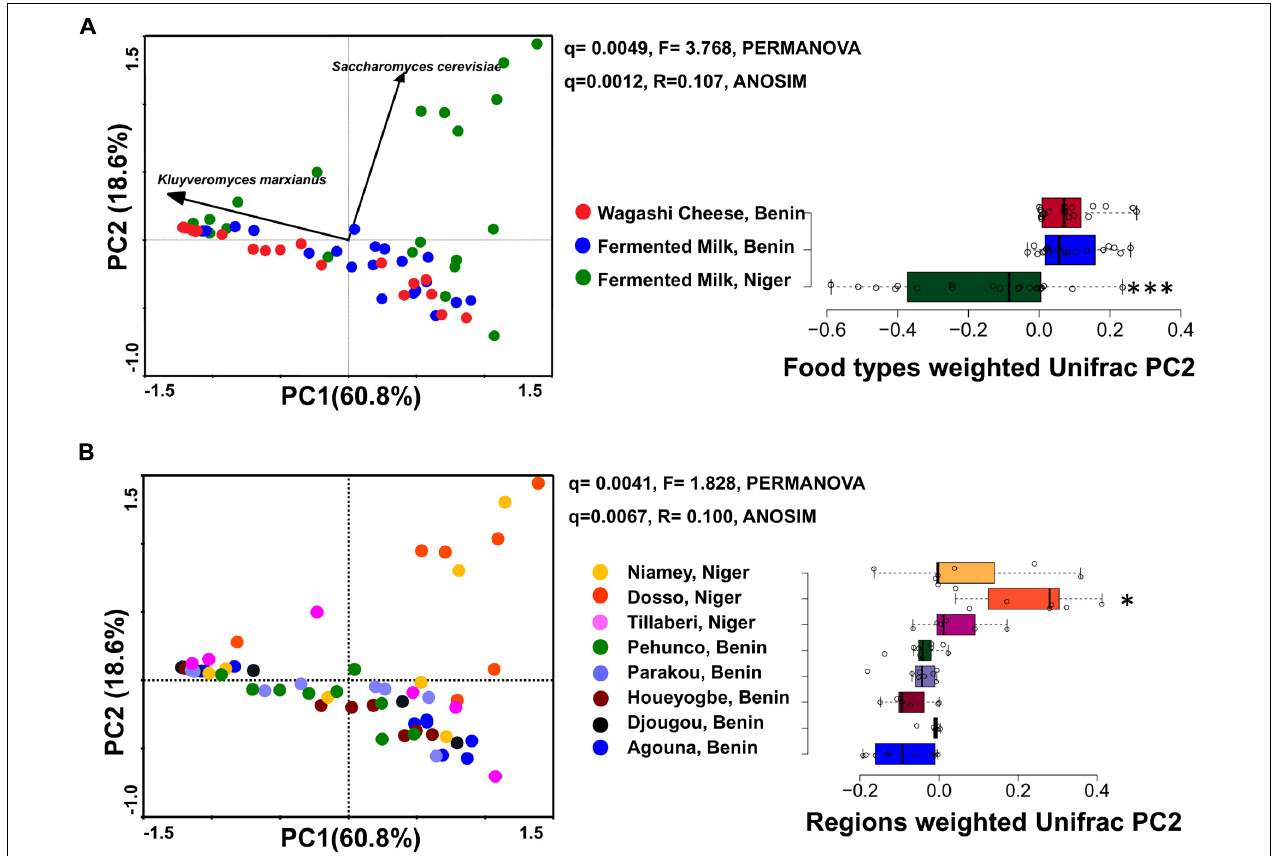
FIGURE 2 | PCA plots show the difference in the yeast community structure among the fermented milk products of Niger and Benin (A) and the regions of sample collection (B) . The direction of yeast species with significant association is indicated with arrows. PERMANOVA and ANOSIM used to visualize the separation among the groups using Bray–Curtis distance and the significance in difference was expressed as Bonferroni corrected q -values. The horizontal box plot shows the principal coordinates of weighted Unifrac that significantly differ among the groups (indicated as ∗ q < 0.05, ∗∗∗ q <